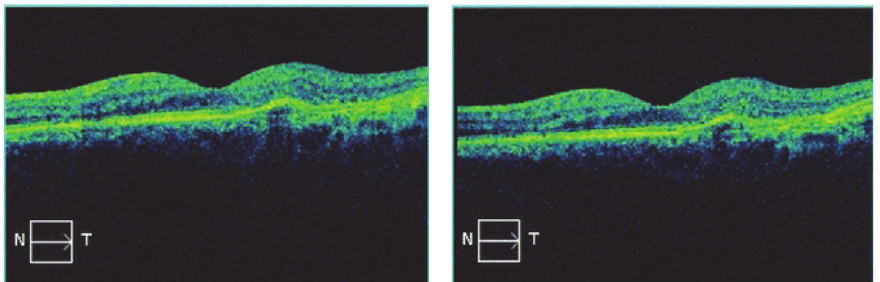
Figure 5: Sequential OCT scans of the left macular area at the 6-month and 12-month follow-up visits, showing absence of subretinal and intraretinal